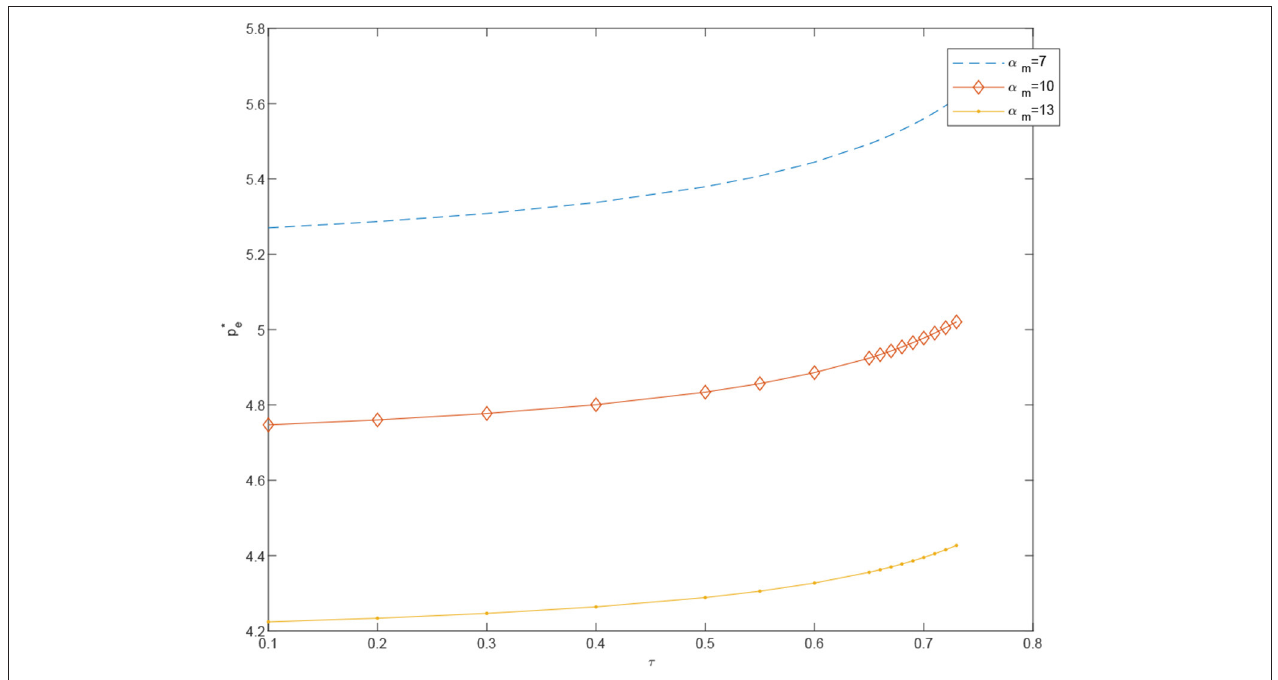
FIGURE 11 | The effect of τ on p ∗ e − O under different α m